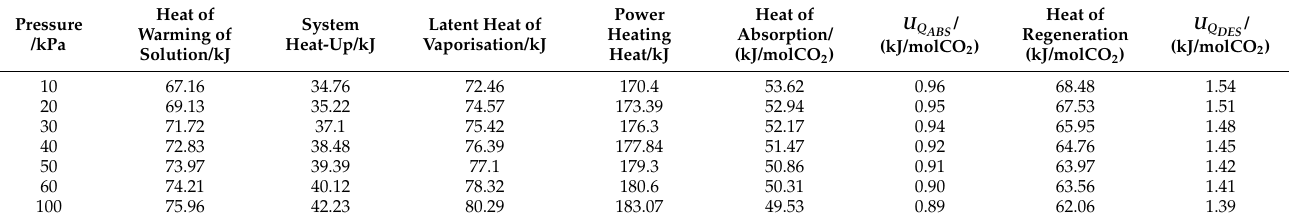
Table 12. Reaction heat data of AEP-DPA under different absorption